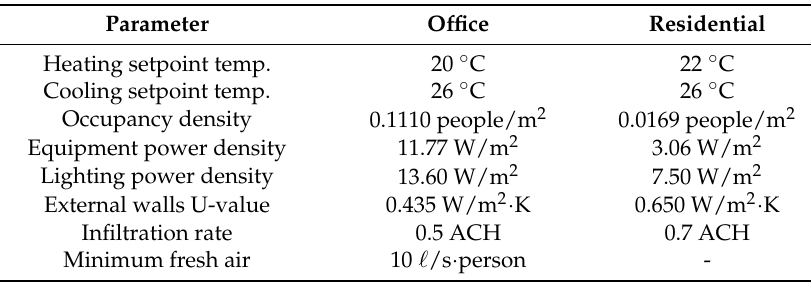
Table 4. Inputs for simulation